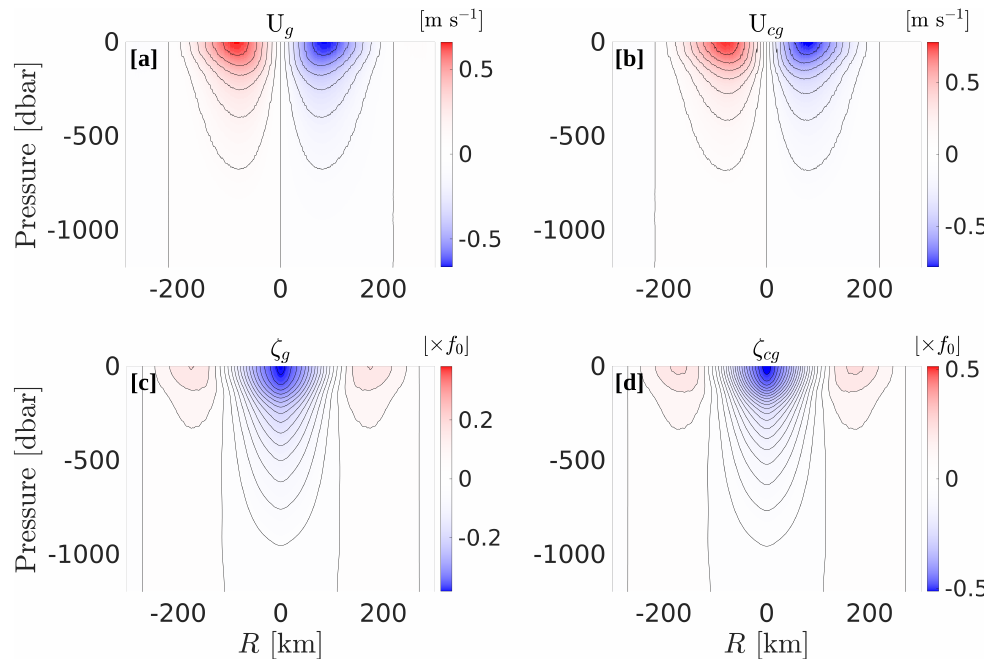
Figure 12. Same as Figure 11 for geostrophic velocity ( a ), cyclogeostrophic velocity ( b ), geostrophic relative vorticity ( c ), and cyclogeostrophic relative vorticity ( d ). The contour interval is 0.1 m s − 1 . Note that the color bars have a different range in each panel.